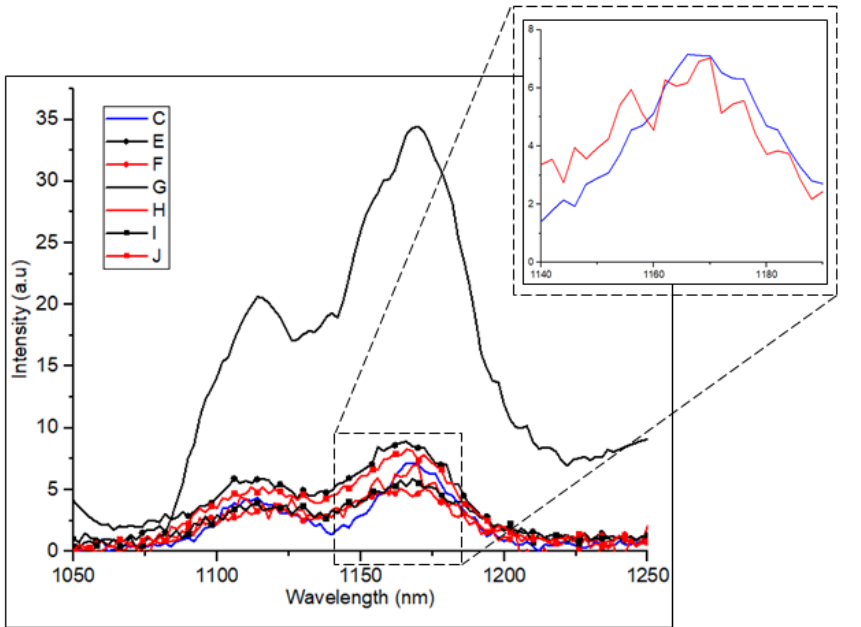
Figure 7. PL spectrum of samples C, E, F, G, H, I and J at 80 K. The black lines represent samples implanted with carbon prior to boron implantation at 10 keV. The red lines represent samples im- planted with carbon prior to boron implantation at 30 keV. The blue line is sample C from the pre- vious result, selected as reference. The highest intensity is observed in sample G with 30/10 keV of carbon and 10 keV of boron implantation. The inset shows the peak at 1170 nm for samples C and H. Laser power is 200 mW. FWHM for sample G is 51 nm (49 meV).